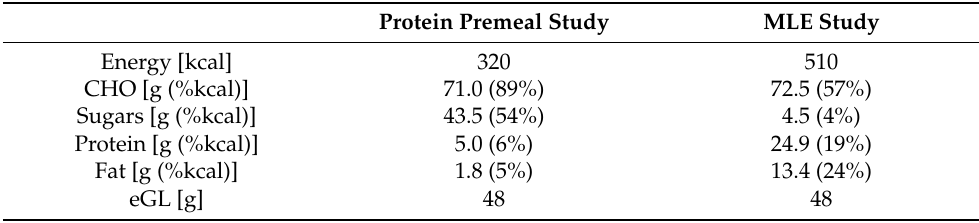
Table 2. Macronutrient composition and estimated glycemic load (eGL) of the standardised meals served in the two studies (CHO: